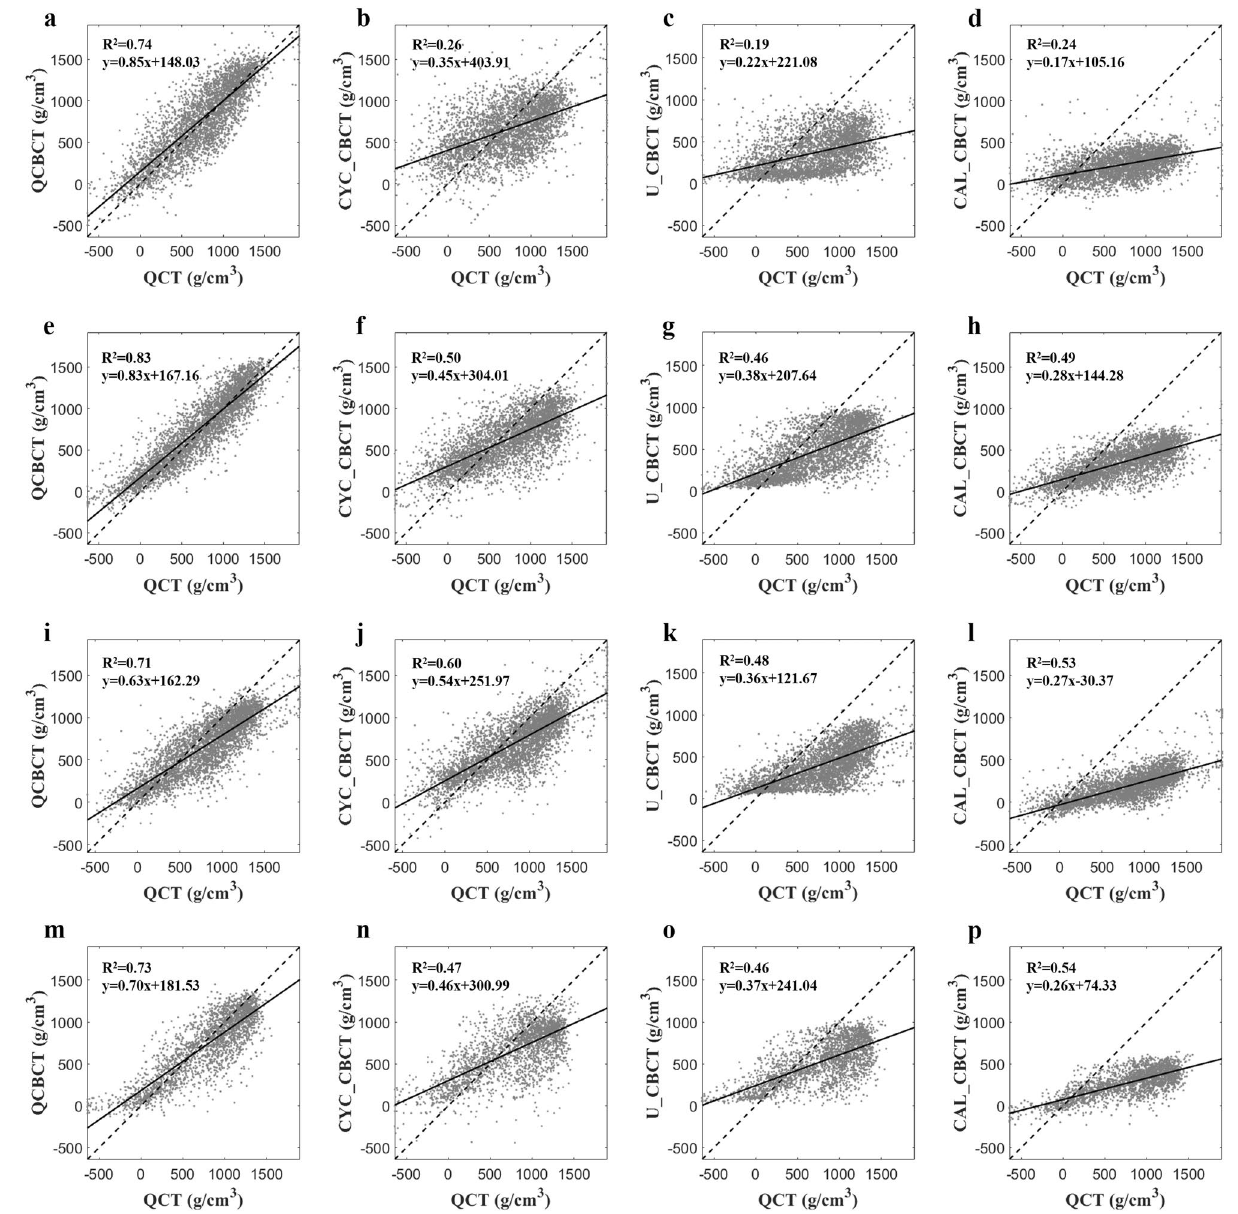
Figure 6. The linear relationships between the original QCT, and QCBCT, CYC_CBCT, U_CBCT, and CAL_ CBCT images. ( a–d ) CBCT images at the maxilla under condition of 80 kVp and 8 mA, ( e–h ) at the mandible under condition of 80 kVp and 8 mA, ( i–l ) at the maxilla under condition of 90 kVp and 10 mA, and ( m–p ) at the mandible under condition of 90 kVp and 10